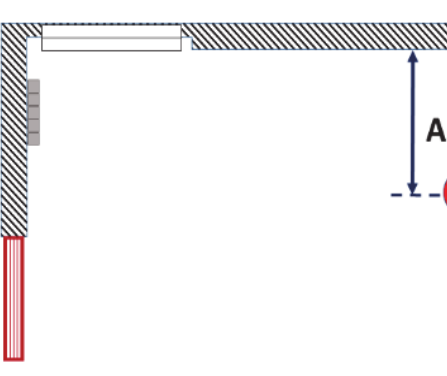
Figure 9. Test #1: map of the room with the robot.